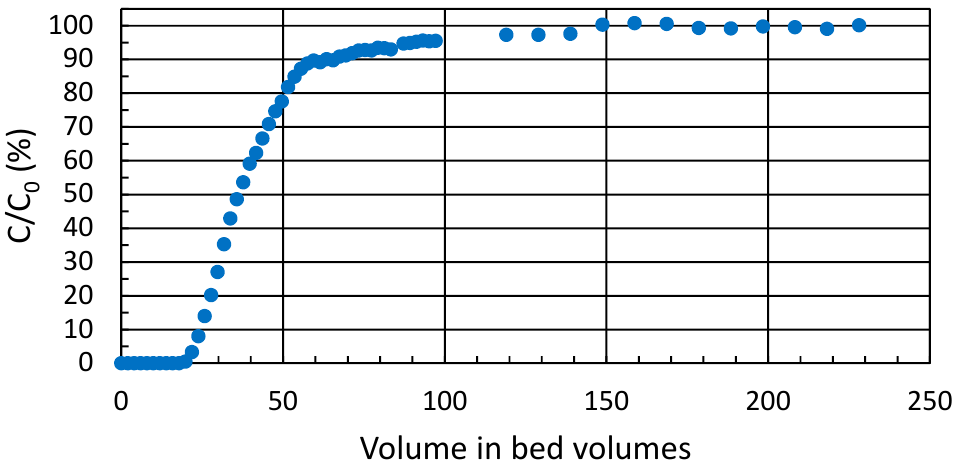
Figure 4. Column breakthrough experiment for Eu(III) for ZrP. Constant feed of 0.001 mol · L − 1 Eu(III) in 0.002 mol · L − 1 HNO 3 with 0.1 mol · L − 1 NaNO 3 . The bed volume is 1.1 mL, the feed rate is 2 BV · h − 1 and mass of the exchanger is 472 mg.